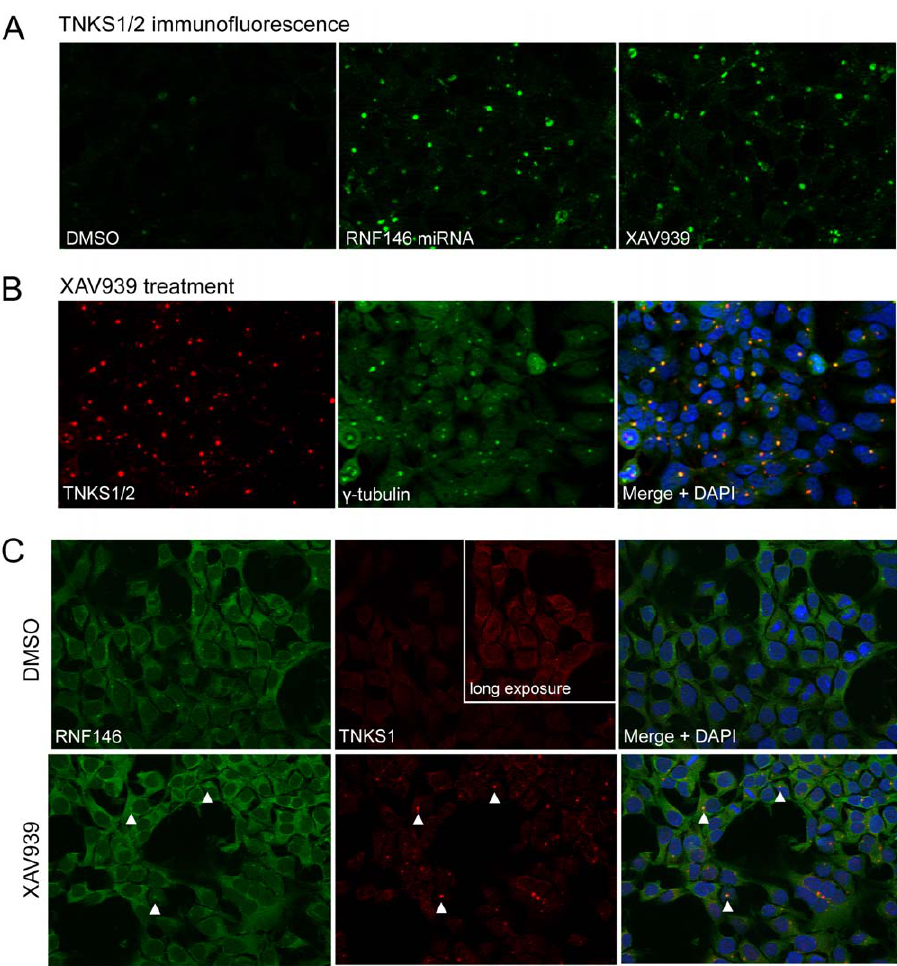
Figure 7. RNF146 RNAi and tankyrase inhibition induce tankyrase puncta in cells. (A) Immunofluorescence imaging of tankyrase (green) in HEK293T cells stably expressing doxycycline-inducible RNF146 miRNA treated with either control DMSO, doxycycline (RNF146 miRNA), or tankyrase inhibitor XAV939. (B) HEK293 cells treated with XAV939 and immunostained for endogenous tankyrase (red) and c -tubulin (green). The merged image shows co-localized tankyrase with c -tubulin (yellow) counterstained for nuclei with DAPI (blue). All images are representative of at least three independent experiments. (C) HEK293 cells were treated with DMSO or XAV939 and immunostained for endogenous RNF146 (green) and tankyrase (red), with DAPI counterstaining (blue) in the merged image. Arrowheads indicate co-localization of RNF146 and tankyrase in puncta.